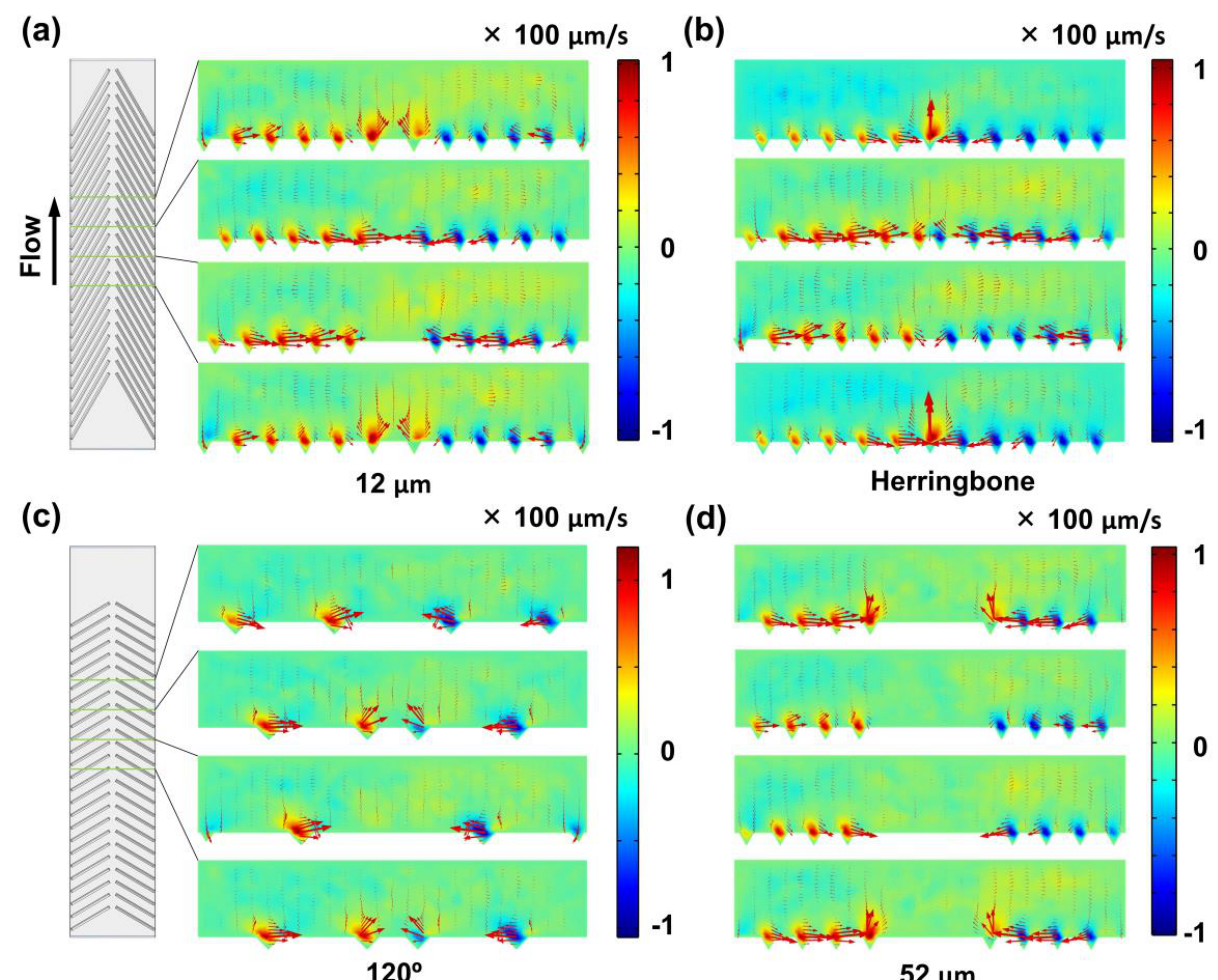
Figure 2. Numerical simulation of 2D vector plots of flow velocity fields at cross-sections of the microchannels with fs laser-engraved grooves. ( a ) 60 ◦ open v-shaped grooves with the middle open space of ~12 µ m. ( b ) 60 ◦ herringbone grooves. ( c ) 120 ◦ open v-shaped grooves with the middle open space of ~12 µ m. ( d ) 60 ◦ open v-shaped grooves with the middle open space of ~52 µ m. The red arrows show the proportional velocity and the direction of its vector.